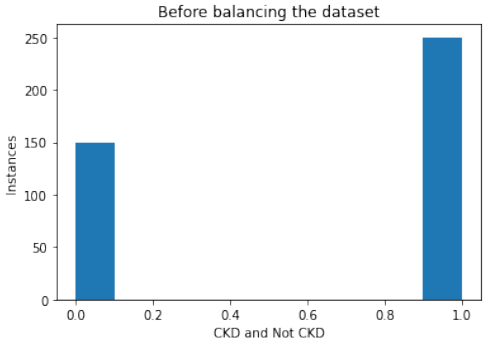
Figure 2. Instances before